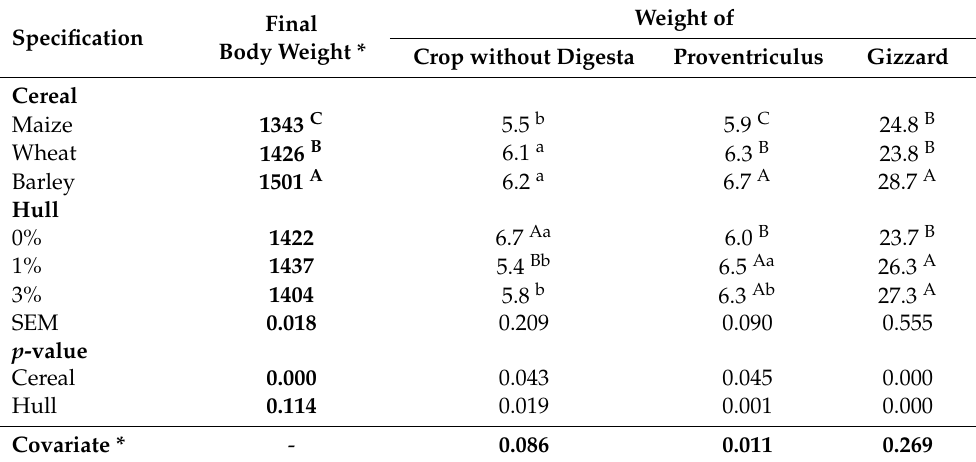
Table 5. Final body weight and weight of organs from the upper part of GIT ( n = 27, in g). Specification